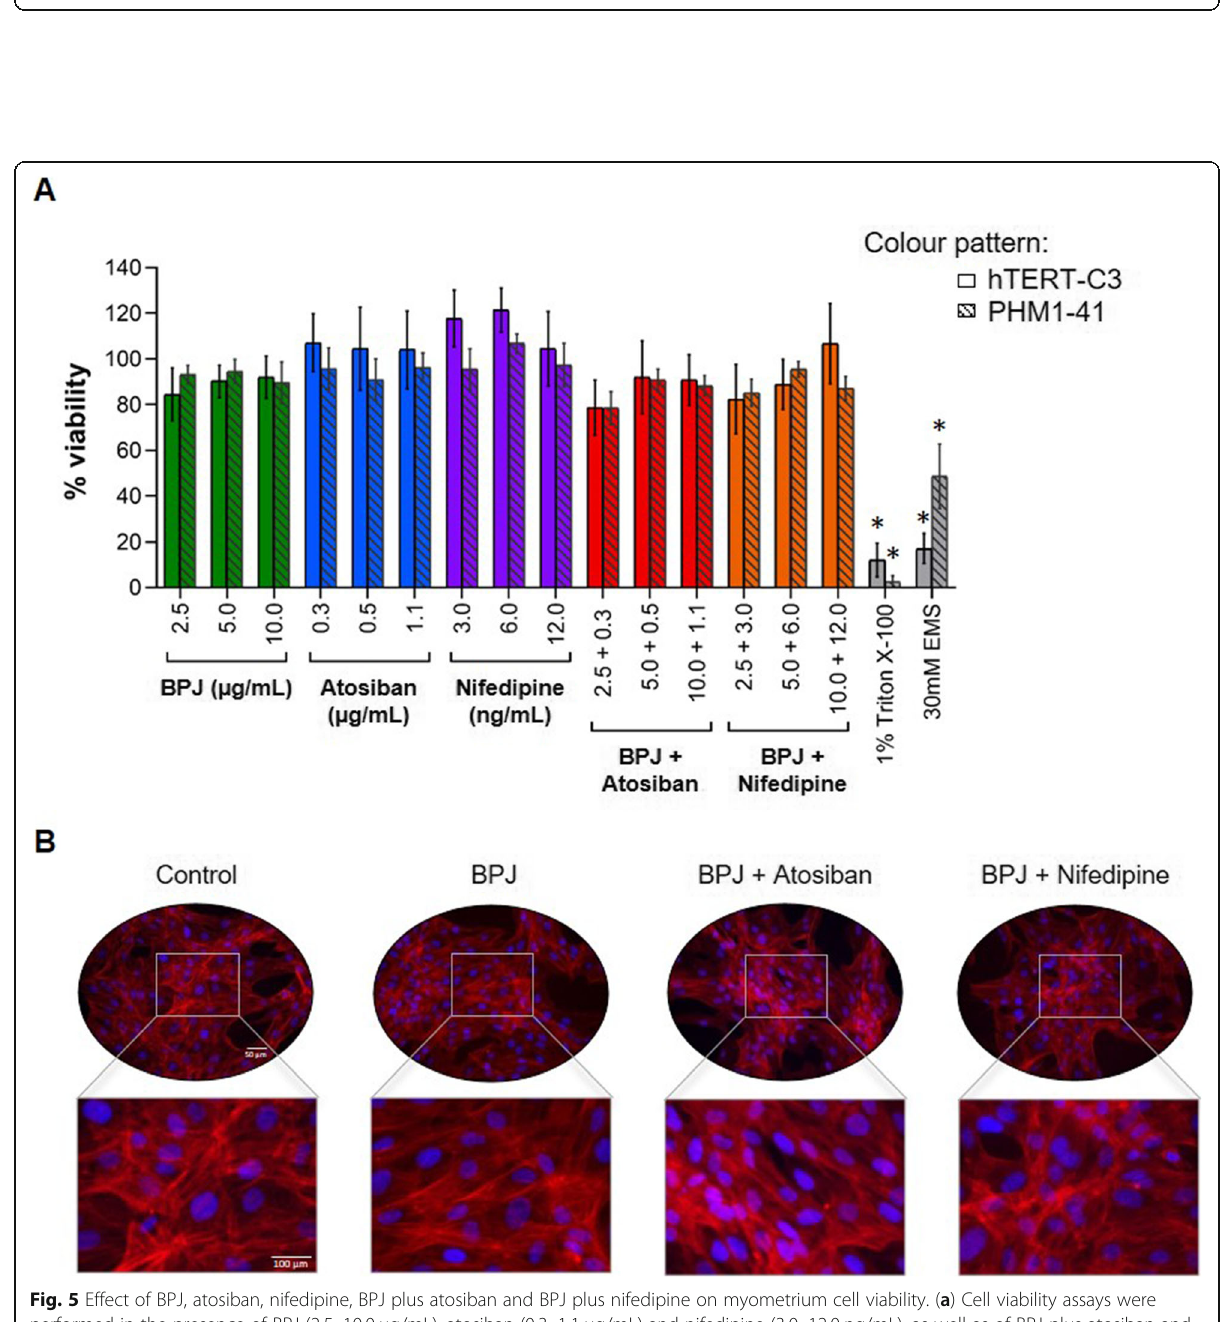
Fig. 5 Effect of BPJ, atosiban, nifedipine, BPJ plus atosiban and BPJ plus nifedipine on myometrium cell viability. ( a ) Cell viability assays were performed in the presence of BPJ (2.5 – 10.0 μ g/mL), atosiban (0.3 – 1.1 μ g/mL) and nifedipine (3.0 – 12.0 ng/mL), as well as of BPJ plus atosiban and BPJ plus nifedipine (same concentrations as with single treatments) using hTERT-C3 and PHM1 – 41 human myometrium cell lines. Cells were incubated with the test substances for 24 h. Triton X-100 (1%) and ethyl methanesulfonate (30 mM) were used as positive controls. Data is presented as mean ± SEM of 4 independent experiments ( n = 4), each carried out in quadruplicate; * p < 0.05. ( b ) Staining of nuclei (blue) and actin (red) from hTERT-C3 cells untreated (i.e. control) or upon treatment with BPJ (10.0 μ g/mL), BPJ plus atosiban (10.0 μ g/mL and 1.1 μ g/mL, respectively), and BPJ plus nifedipine (10.0 μ g/mL and 12.0 ng/mL, respectively). The images are representative of four independent